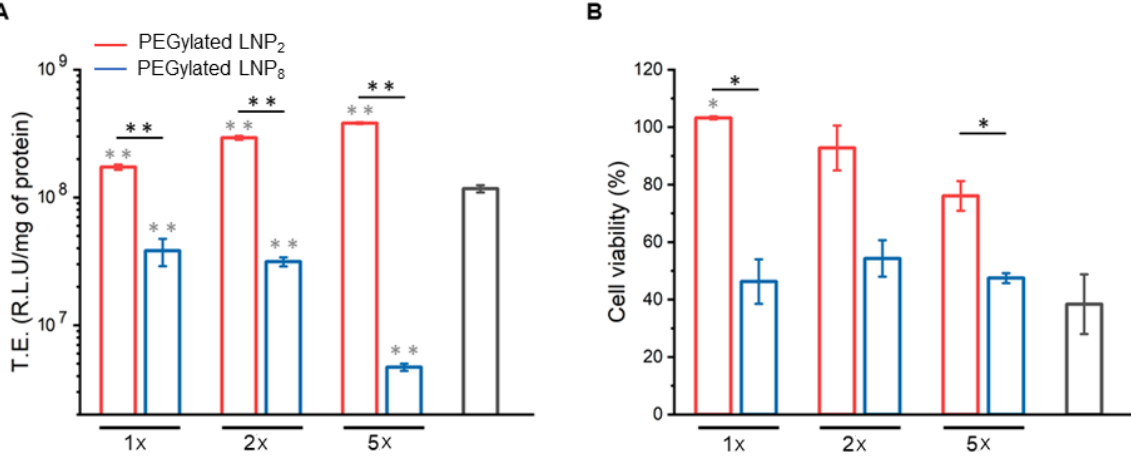
Figure 4. PEGylated LNP 2 (red histograms) and LNP 8 (blue histograms) transfection efficiency (TE) ( A ), expressed as Relative Light Unit (R.L.U.) to milligrams of proteins and cell viability ( B ), expressed as percentage with respect of untreated cells, at three different pDNA conditions, namely 1µg (1×), 2µg (2×) and 5 µg (5×), towards HEK-293 cells. All values are compared to the positive control LipofectamineTM 3000 (grey histograms) (1×). Statistical significance was evaluated using Student’s t -test: * p < 0.05; ** p < 0.01 (grey asterisk represents significance with respect of Lipofectamine TM 3000, no asterisk means lack of significance).